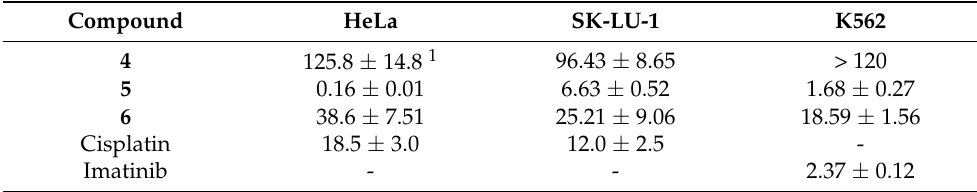
Table 1. Cytotoxicity (IC 50 [ µ M] ± SE) for compounds 5 and 6 and reference compounds 4 , cisplatin, and imatinib on different cancer cell